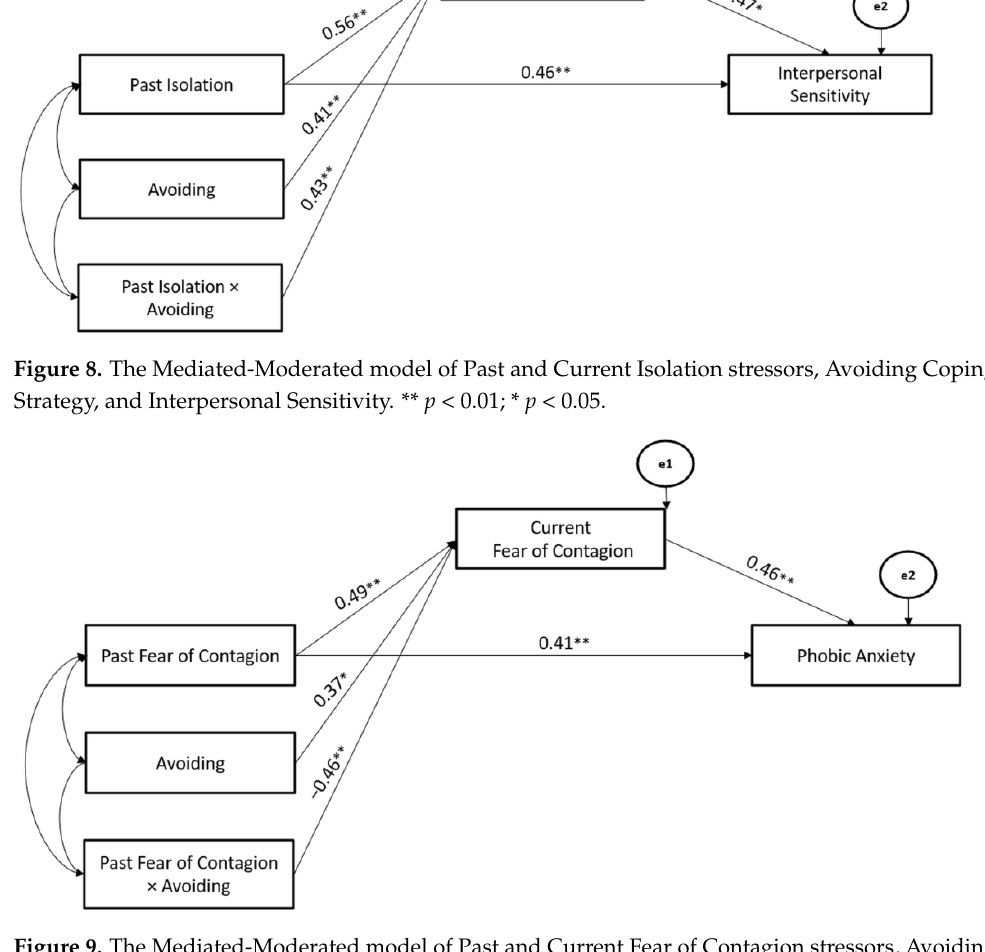
Figure 9. The Mediated ‐ Moderated model of Past and Current Fear of Contagion stressors, Avoiding Coping Strategy, and Phobic Anxiety. ** p < 0.01; * p < 0.05.